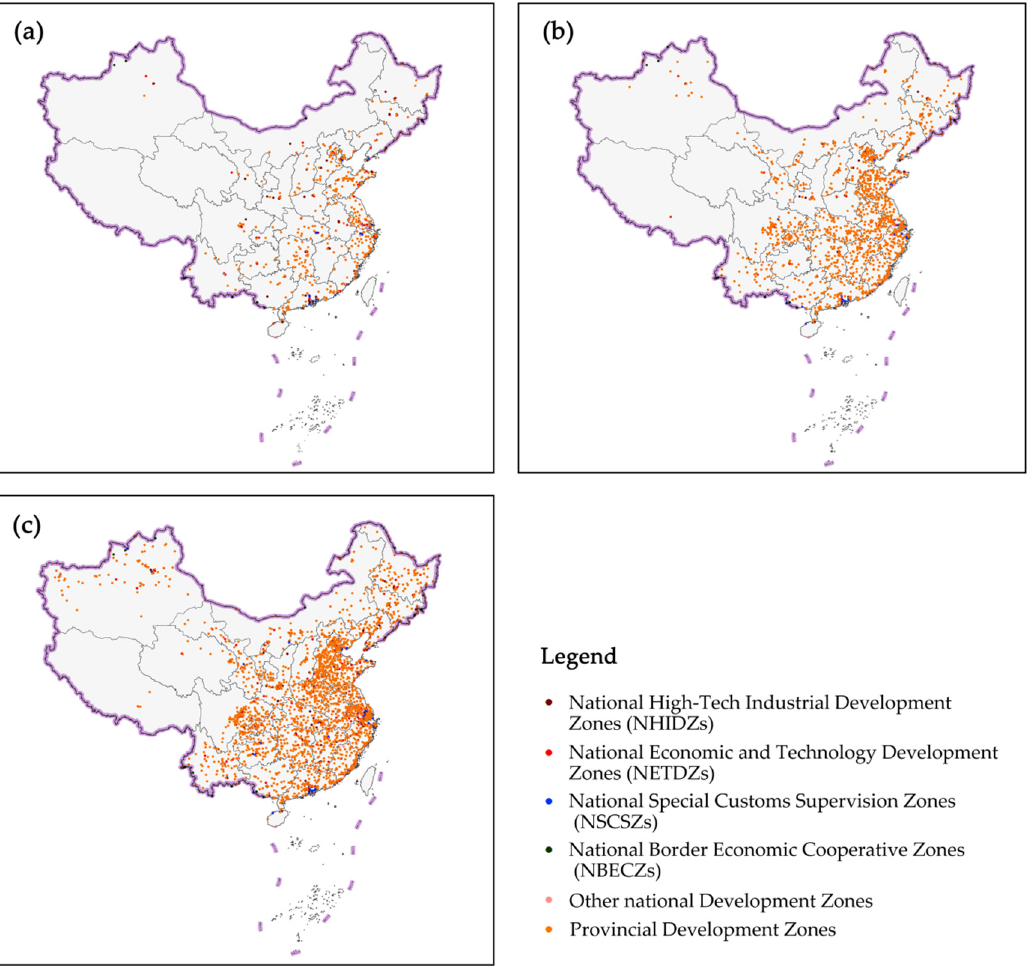
Figure 4. Establishment and distribution of China’s development zones. ( a ) Distribution of devel- opment zones nationwide in 2000; ( b ) Distribution of development zones nationwide in 2008; ( c ) Distribution of development zones nationwide in 2018. Source: Prepared by the authors.